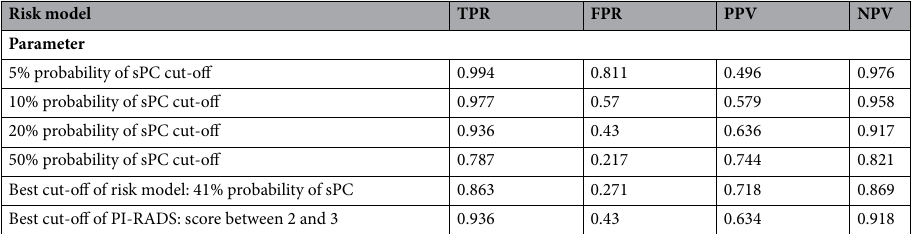
Table 4. Prediction errors for diagnosis of sPC as 5%, 10%, 20%, 50% and best cut-offs for risk model and PI-RADS score . FPR false positive rate, NPV negative predictive value, PI-RADS prostate imaging reporting and data system, PPV positive predictive value, sPC clinically significant prostate cancer, TPR true positive rate.